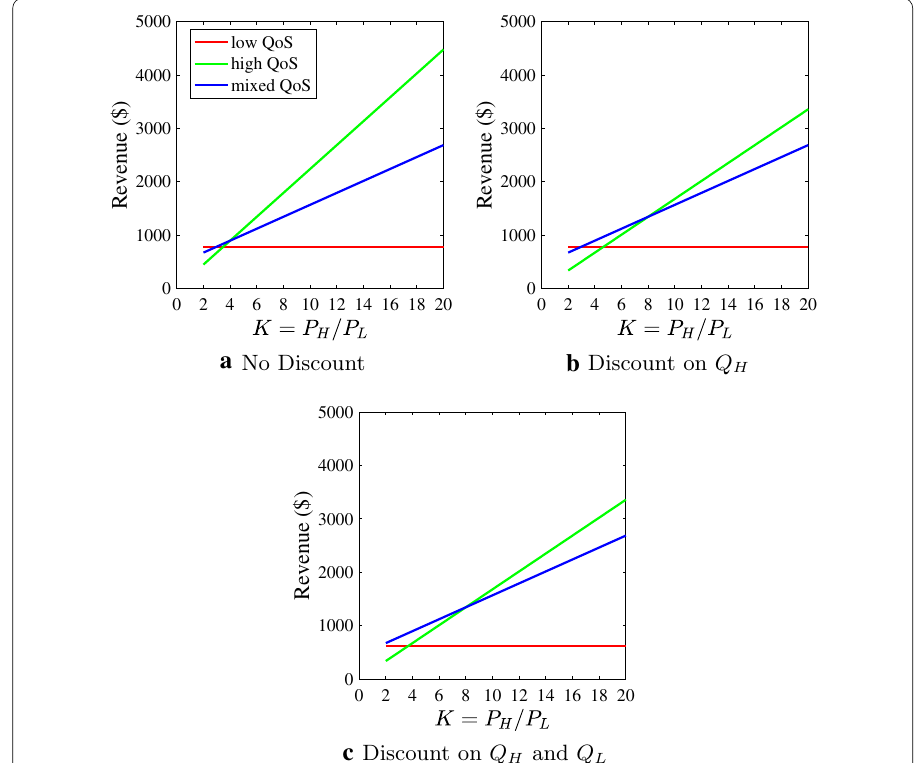
Fig. 3 Revenue for the three QoS scenarios for the cases with (i) no discount, (ii) 50% discount for N H − N H , M high QoS users, (iii) discount as in (ii) along with 20% discount for N L − N L , M low QoS users. Technical parameters: f = 800 MHz, outdoor. The choice of the QoS class is